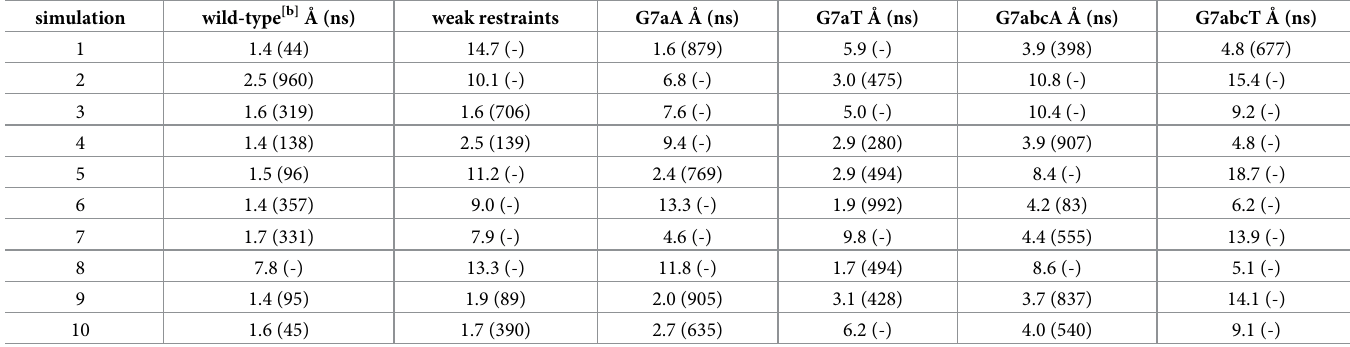
Table 1. Root-mean-square deviation and folding time of triple helices starting from 10 different start structures simulation